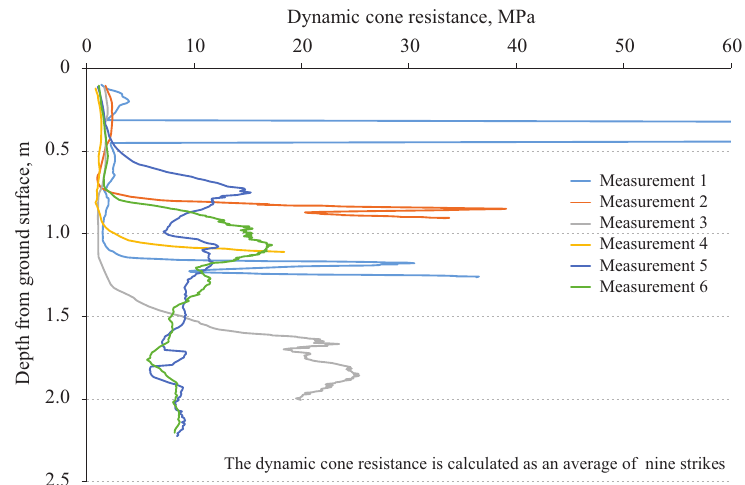
Figure 10. Measurement results for the km137